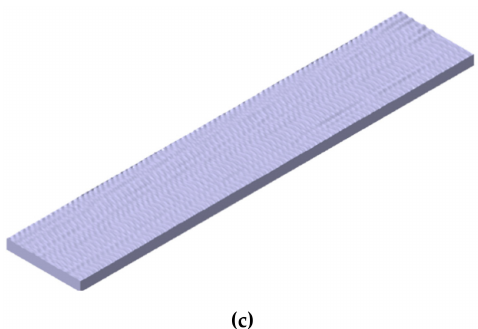
Figure 6. Three-dimensional models generated by the proposed method: ( a ) Rough; ( b ) medium rough; ( c ) smooth